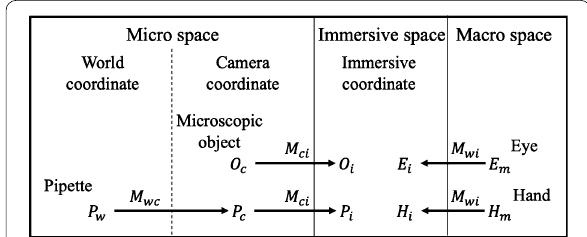
Fig. 9 Mapped model of the immersive space configuration